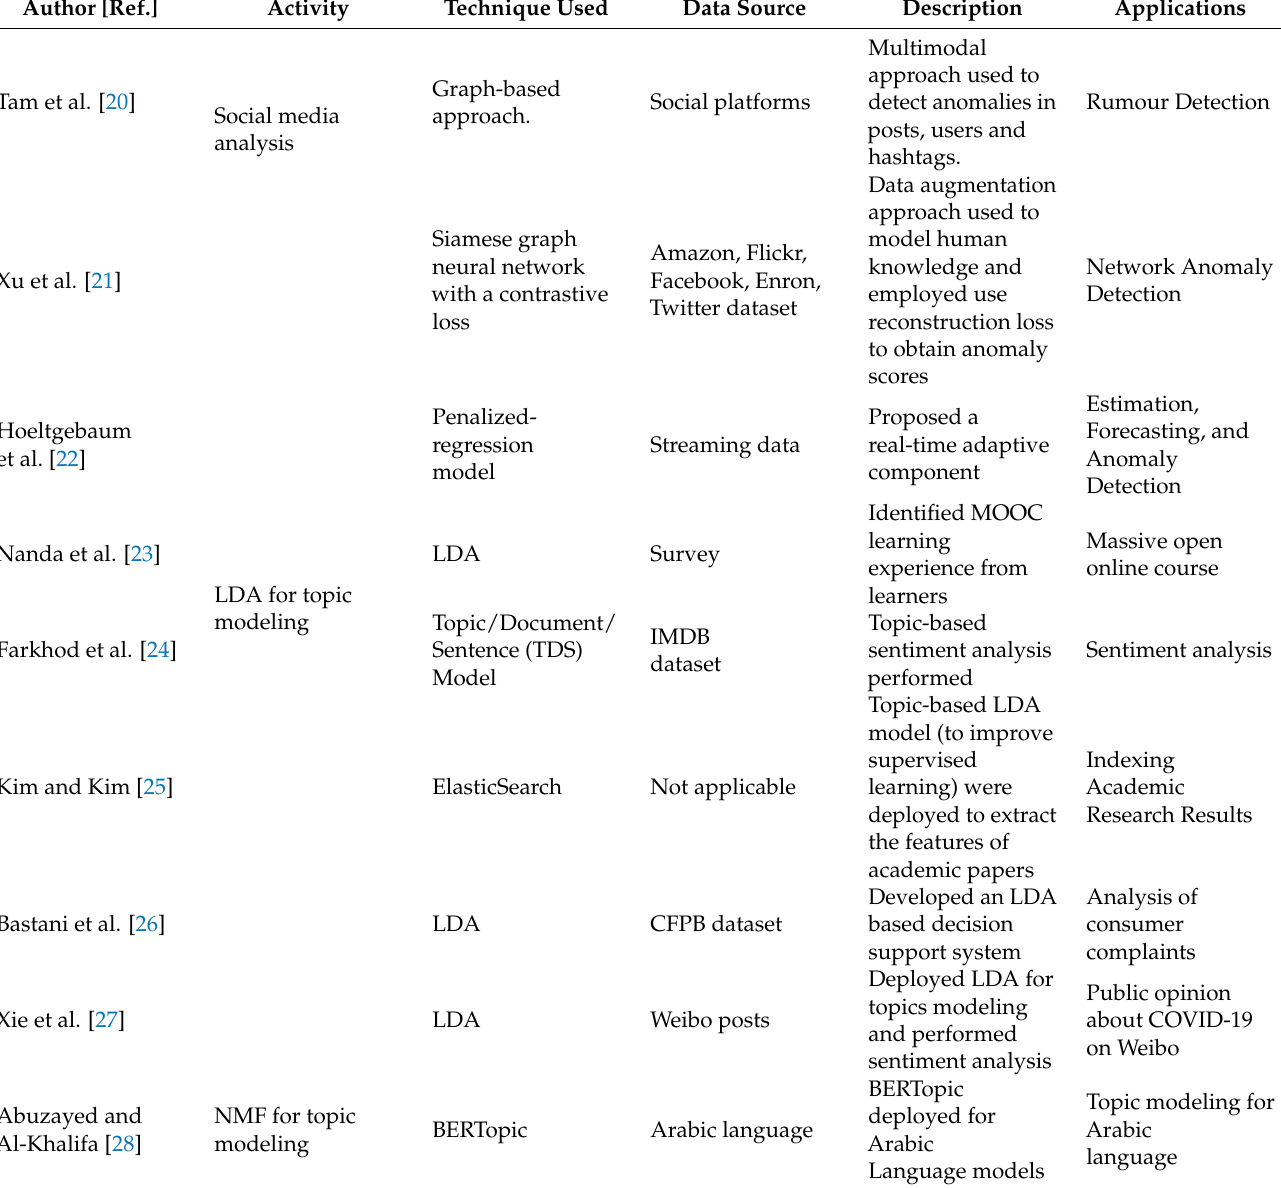
Table 1. Summary of recent development on LDA and NMF for topic